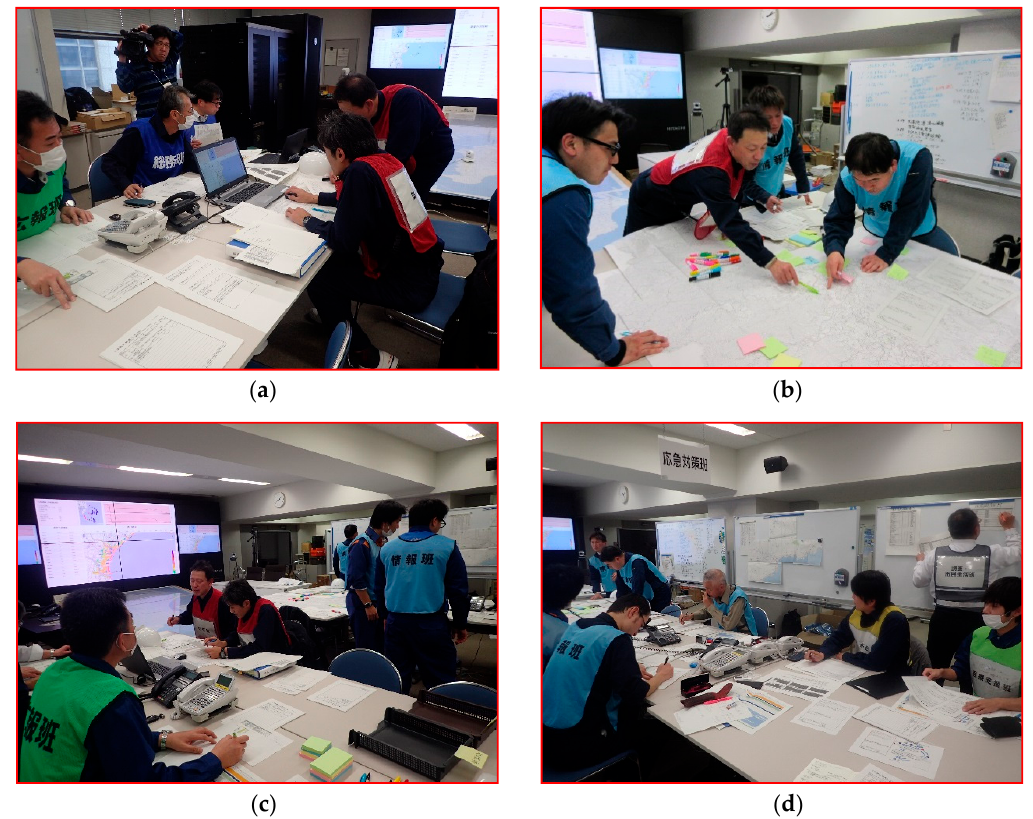
Figure 10. Photographs of the first TTX: ( a ) shows use of the Real-Time Tsunami Prediction system; ( b ) shows the gathering of the information on the map; ( c ) shows discussion of the disaster response and the main monitor; ( d ) shows writing information on the white board.